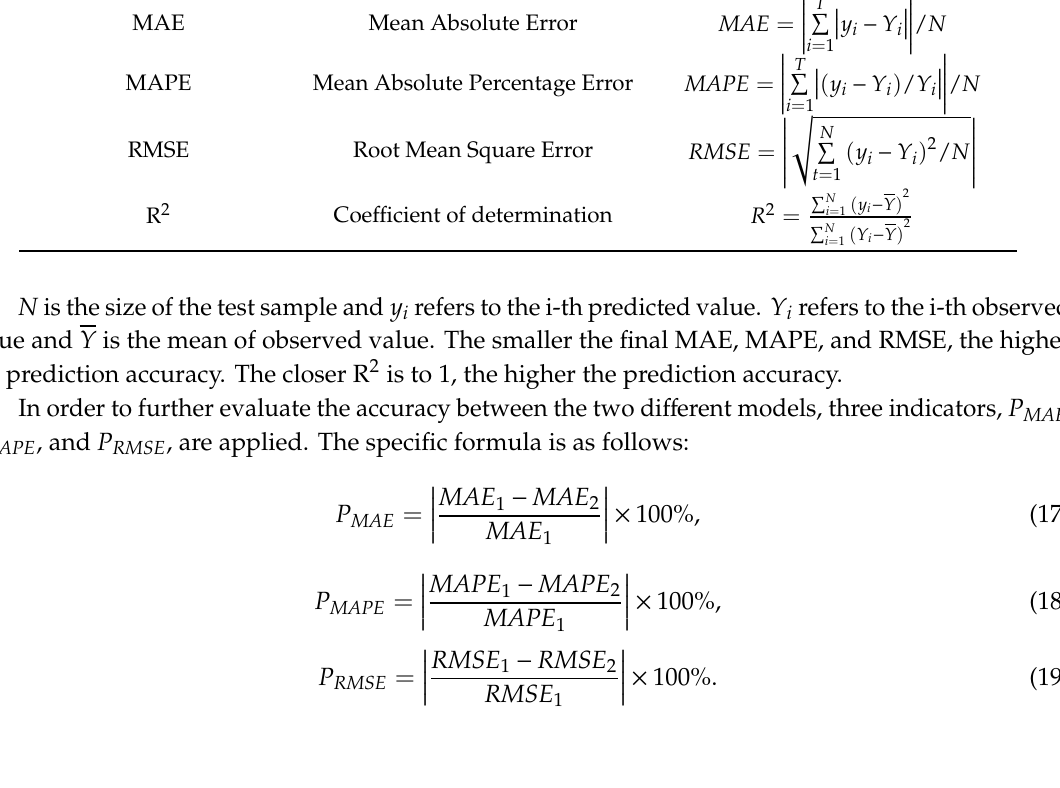
Figure 3. Schematic diagram of multi-step prediction.